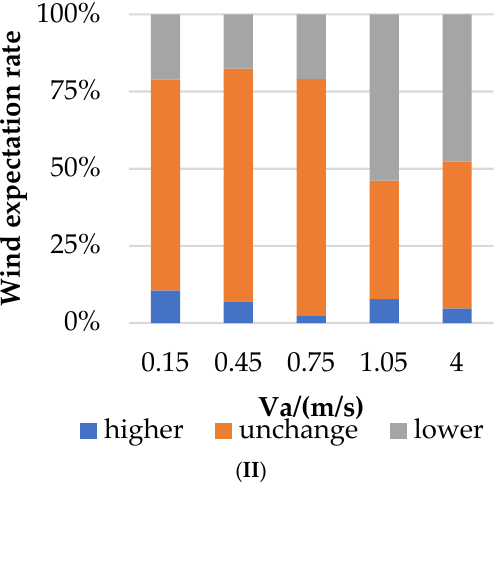
Figure 11. Metabolic rate, clothing insulation, and average wind speed at the lake side.